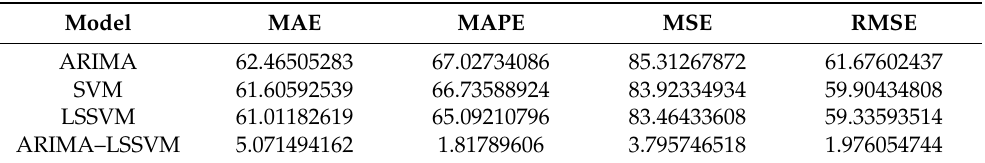
Table 8. Percentage improvement of the proposed models with other forecasting models (the COVID- 19 cases of daily new death